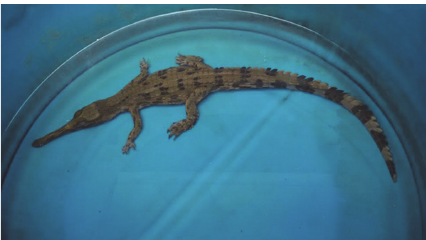
Figure 3: Tomistoma caught in March 2015 at Bunga-Baki River, Serian (total length = 0.4